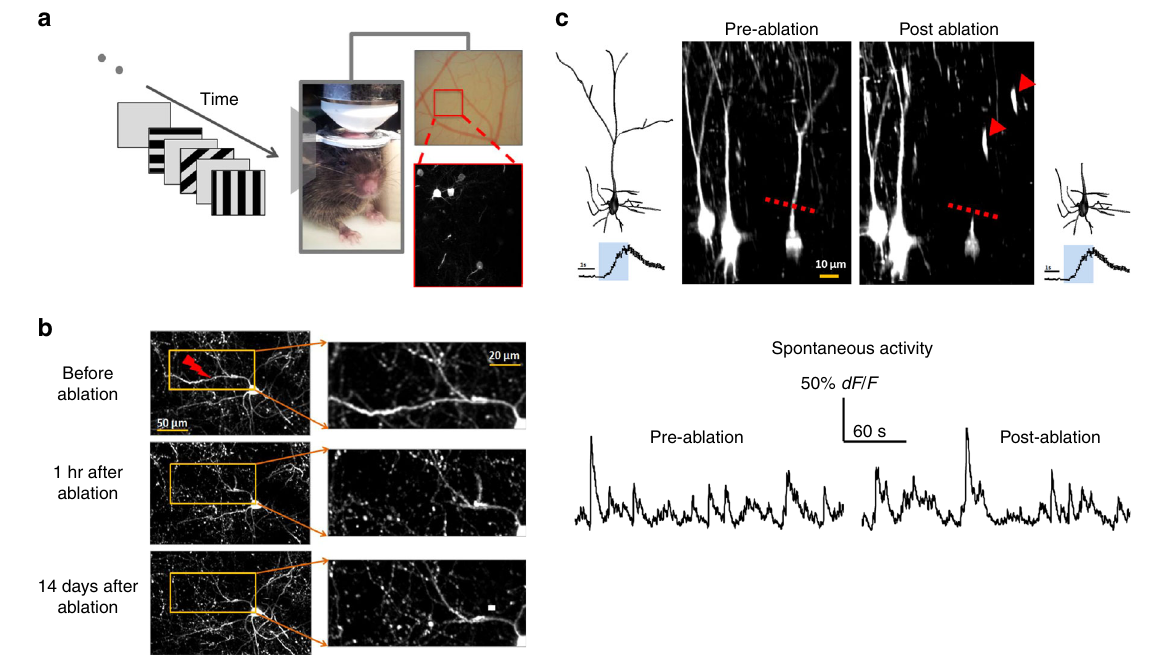
Fig. 1 In vivo 2-photon laser dissection of apical dendrites in mouse primary visual cortex. a Experiment set-up. Left: visual stimulus. Middle: mouse under the objective. Right top: optical image of the surface of V1. Right bottom: two-photon image acquired from the inset showing sparse GCaMP6s-labeled neurons. b Dendritic arbor before (top), 1 h (middle) and 14 days (bottom) after targeted laser-dissection of a single dendritic branch of a GFP-expressing neuron (red arrow: ablation point). Right panels zoom in. c Center: 3D renderings of the target neuron and its neighboring control neurons before (left) and after (right) apical dendrite ablation. Broken red line: the ablation point. Red arrows: GCaMP fi lled remnants of the severed apical dendrite. 3D reconstruction of target neuron before (far left) and after (far right) apical dendrite ablation. d Spontaneous GCaMP6s activity of the example neuron before and after apical tuft